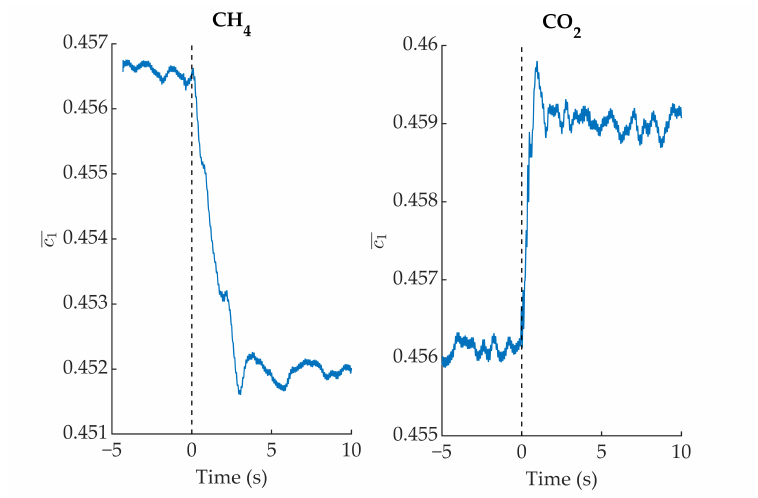
Figure 7. c 1 evolution when CH 4 and CO 2 are introduced into the gas